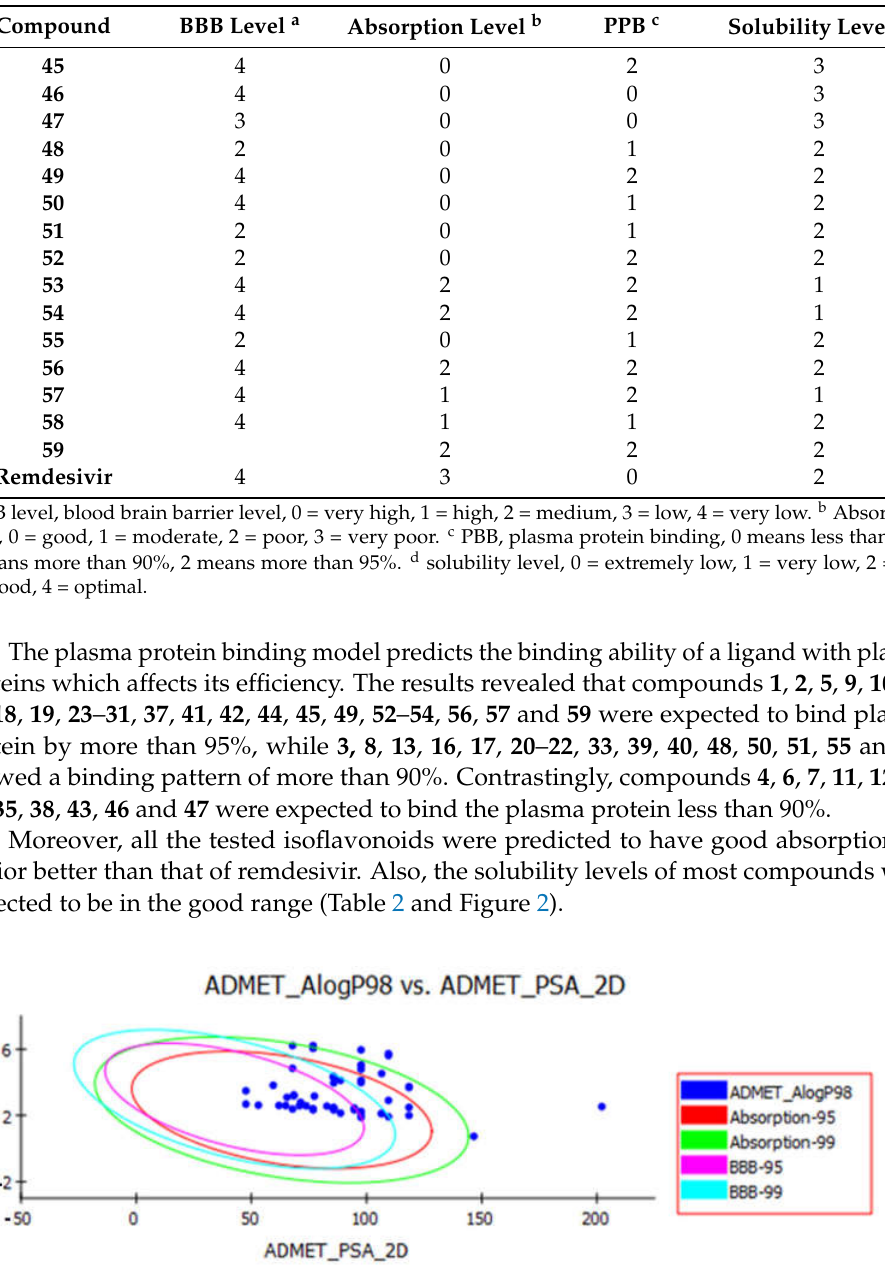
Figure 2. The expected ADMET study of the designed compounds and remdesivir